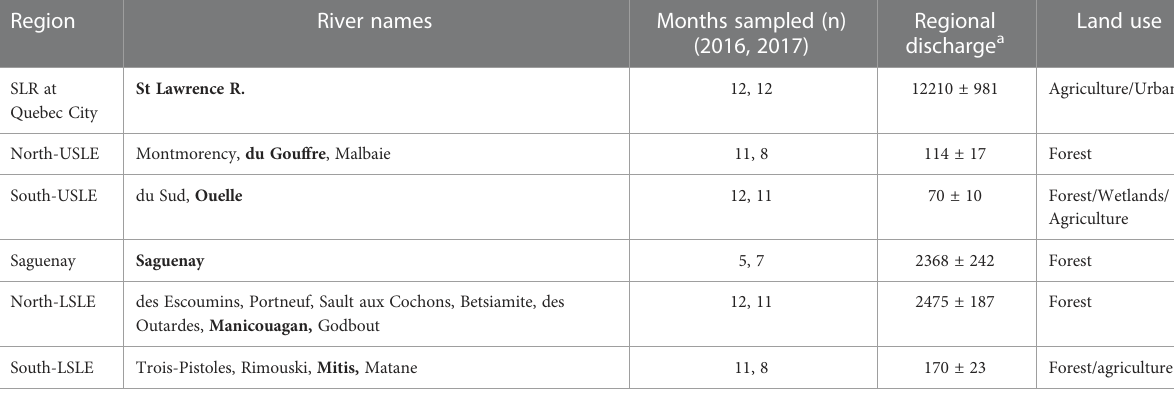
TABLE 1 Mean annual discharge (m 3 /s) of tributaries by region of the St Lawrence estuary. Region River names Months sampled (n)